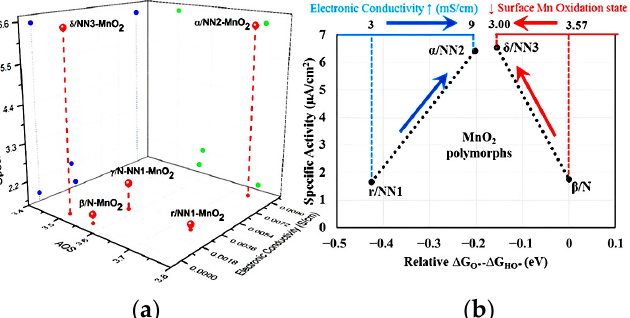
Figure 3. ( a ) Specific OER activities of different polymorphs MnO 2 [β/N-, γ/N-NN 1 -, r/NN 1 -, α/NN 2 - , and δ/NN 3 -MnO 2 ] with their oxidation state of Mn (activated oxygen species (AOS)) and bulk electronic conductivities. Blue and green dots represent projection in specific activity–electronic conductivity and specific activity–AOS planes, respectively. ( b ) Volcano-based relationship for the specific OER activity of MnO 2 polymorphs with the computed universal descriptor ∆ G O* − ∆ G HO* (eV) (relative to the native phase β /N-MnO 2 ). Reproduced with permission from Ref. [69]. Copyright 2019, American Chemical Society.